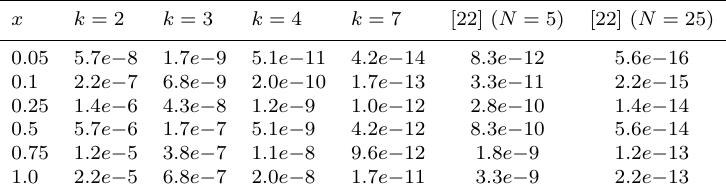
Table 3. Absolute error of Example 3.